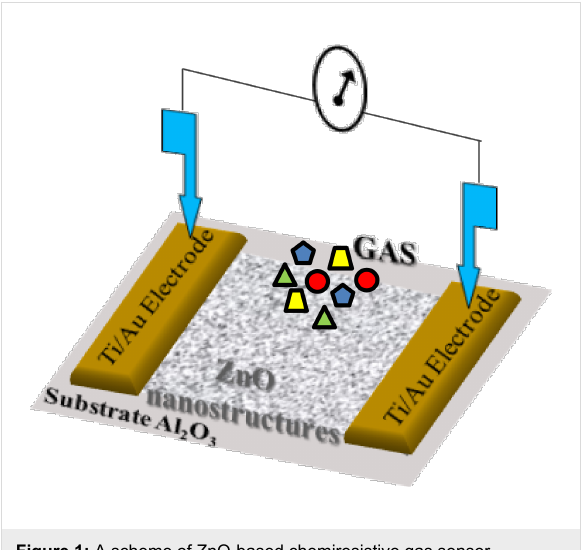
Figure 1: A scheme of ZnO-based chemiresistive gas sensor.